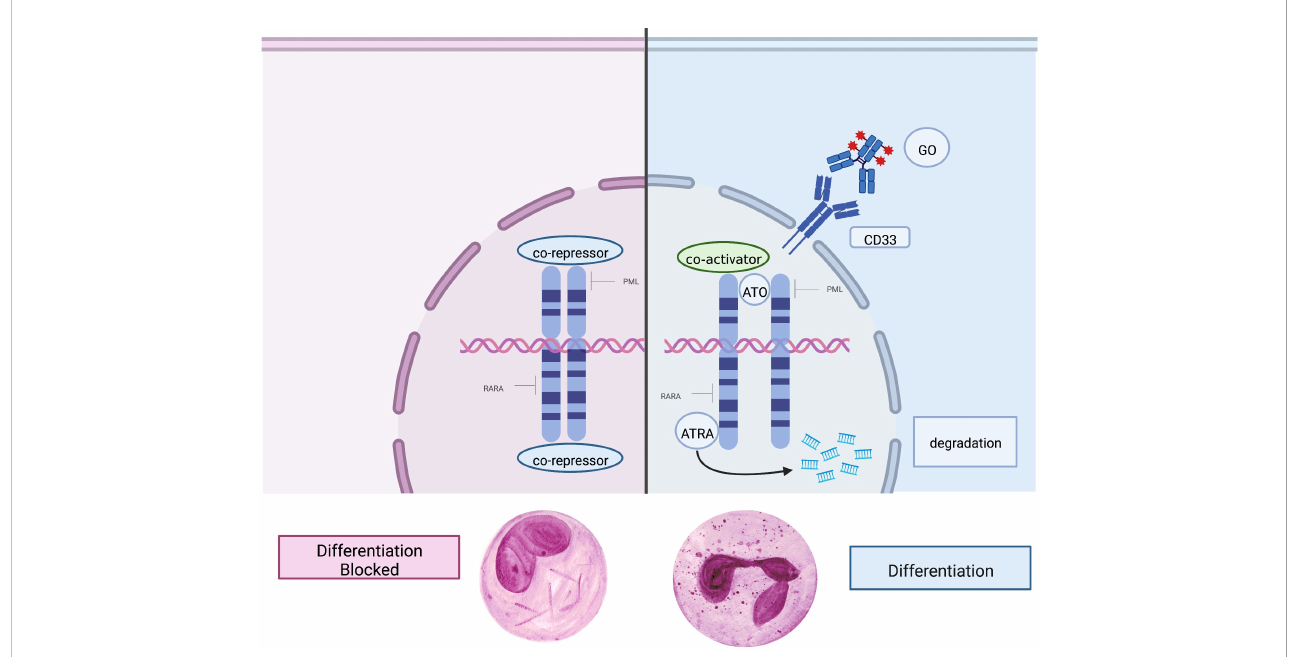
FIGURE 2 Mechanism of action of key agents. Left: In APL, the PML-RAR a fusion protein causes a block in differentiation and drives malignant promyelocytic proliferation. Right: The mutated retinoic acid receptor on the cell surface is targeted and bound by ATRA (all-trans retinoic acid) and ATO (arsenic trioxide), which promotes terminal differentiation, degradation of oncogenic proteins, and apoptosis. GO (gemtuzumab ozogamicin) is an antibody-drug conjugate which binds CD33 on the cell surface and when endocytosed releases the chemotherapeutic agent calicheamicin, causing cell